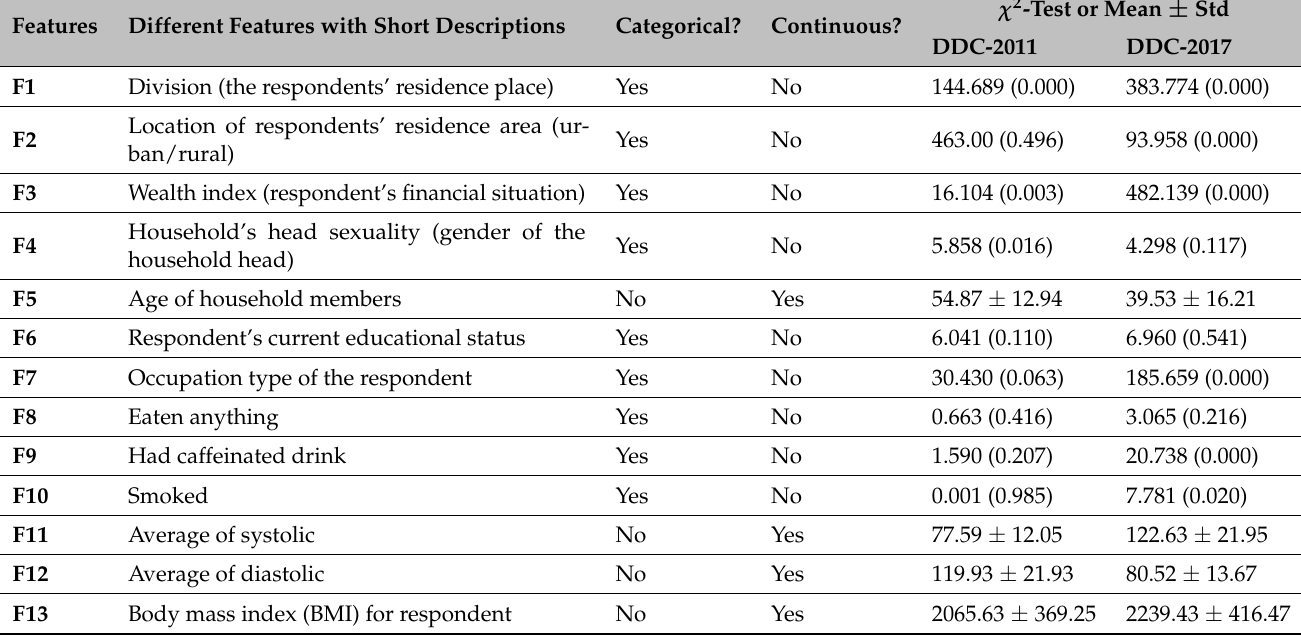
Table 3. The features (categorical/continuous) employed in this research are described in detail. For categorical variables we used an χ 2 -test, whereas for continuous variables a mean ± std is engaged to represent the substantial relationship with diabetes disease